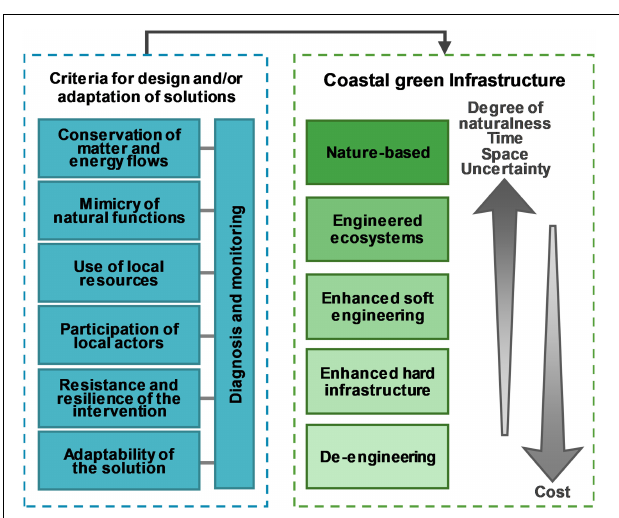
FIGURE 2 | Interaction of the different elements. De-engineering (relocating landward, or removing, infrastructure) is the only alternative if space is insufficient to allow for ecosystem processes, the available time for ecosystem responses is insufficient (too short) and the degree of uncertainty of the solution must be